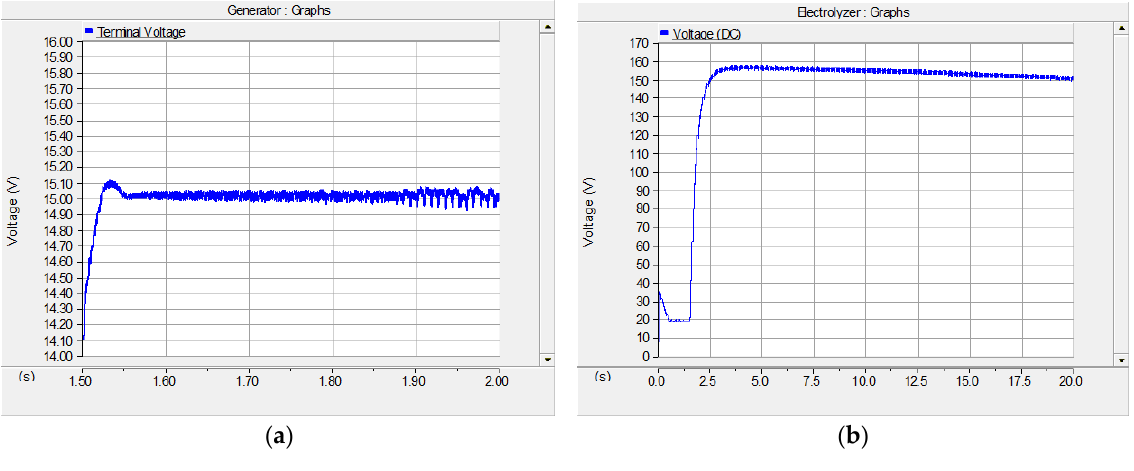
Figure 25. ( a ) Terminal voltage; ( b ) DC voltage.